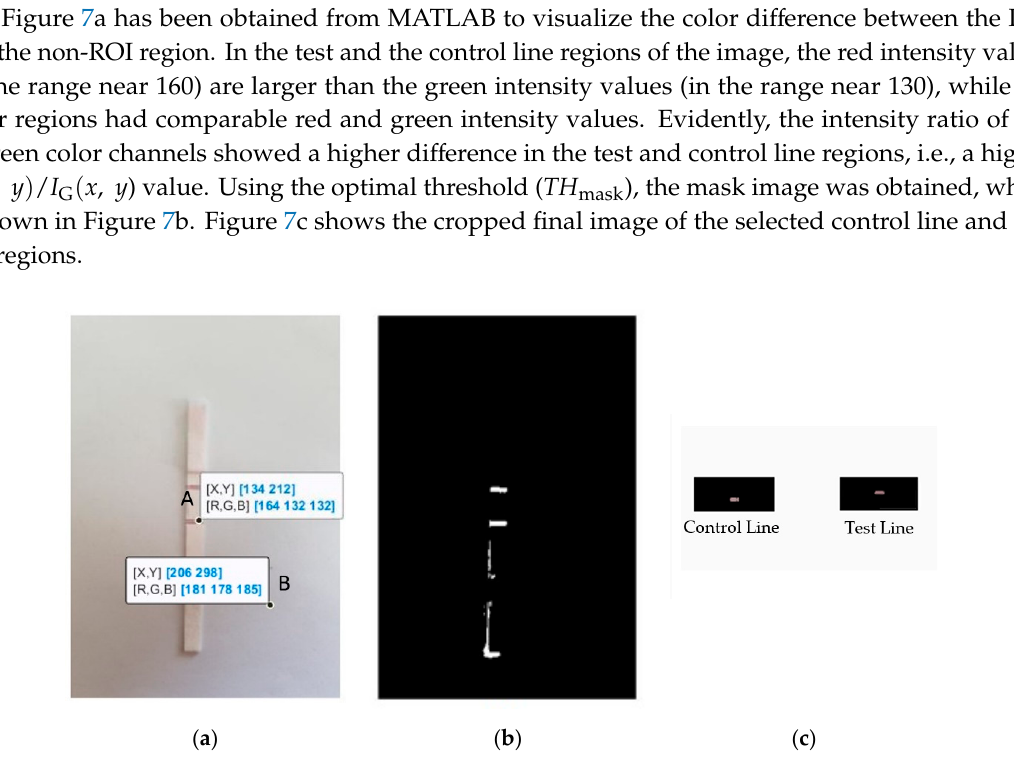
Figure 7. ( a ) Visualization of two pixels in a sample LFA strip image with red, green, and blue channel intensity values. Pixel A is in the test line region and pixel B is in the non-ROI region, ( b ) the calculated mask where the red to green intensity ratio was greater than the threshold TH mask , and ( c ) the extracted control line and test line regions are shown.